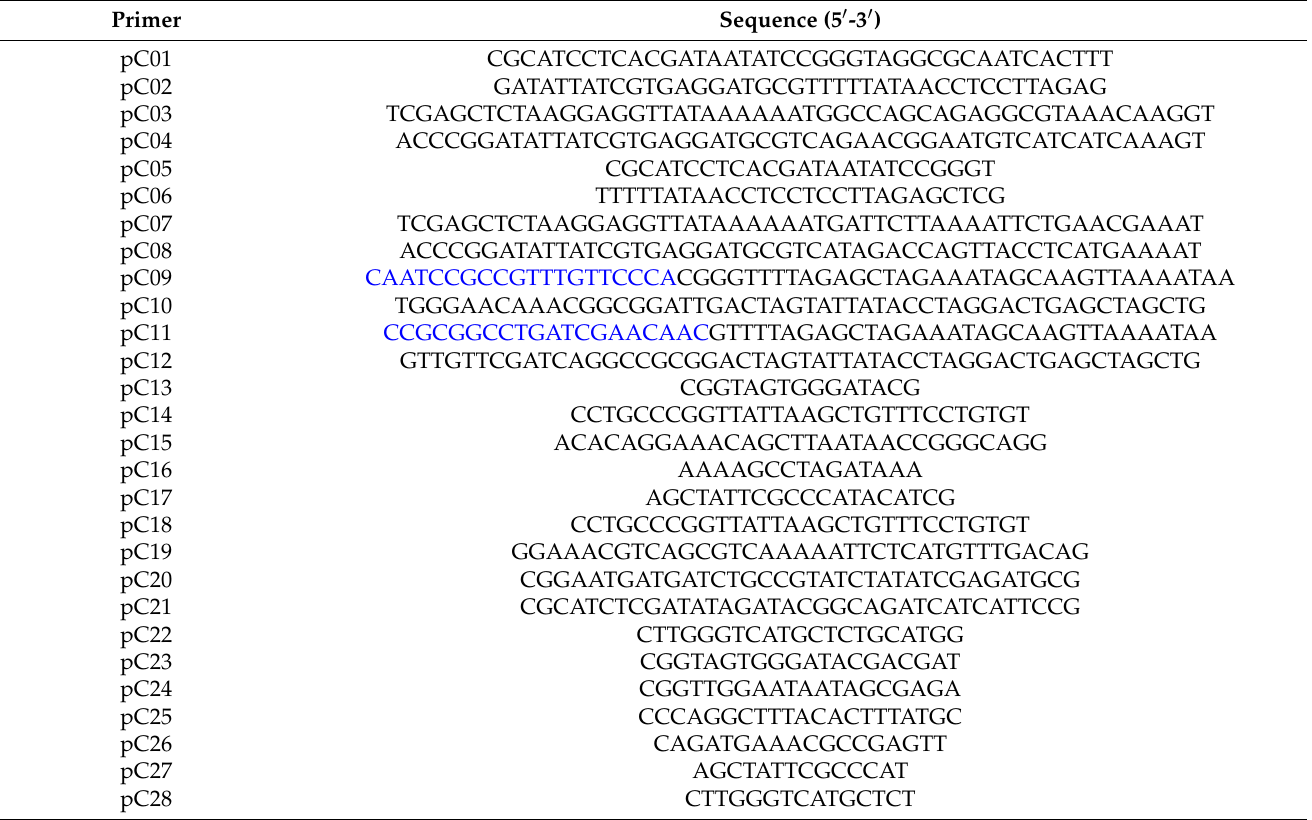
Table 2. The primers used in this study a